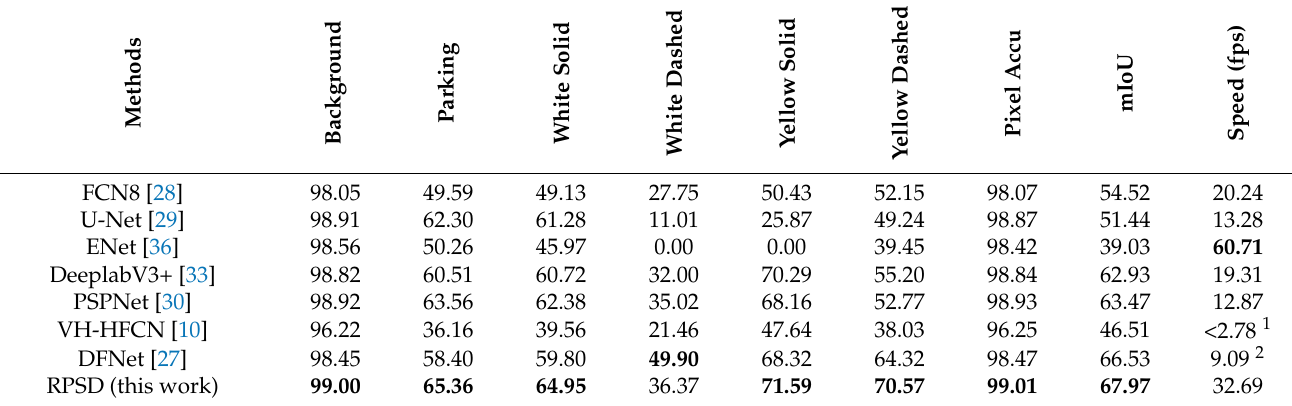
Table 5. Predicted mIoU and inference time for the PSV test set with the reference